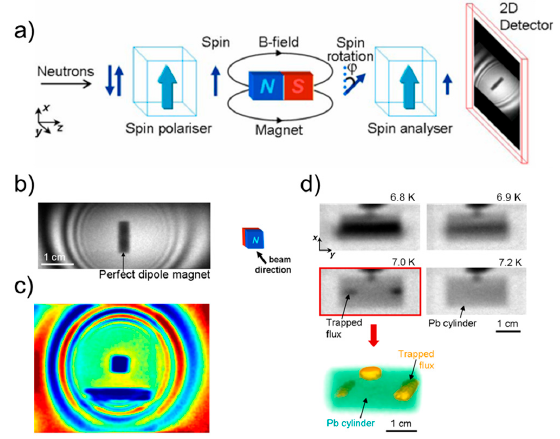
( b ) Field lines surrounding a simple dipole magnet; ( c ) Radiograph showing field lines around a bar magnet levitating over an yttrium-barium-copper-oxide (YBCO) superconductor as in its superconducting state the YBCO expels all magnetic fields and thus repels the permanent magnet (Meissner effect); ( d ) Magnetic field trapped in a polycrystalline lead cylinder at different temperatures around T c = 7.2 K. The trapped flux (yellow regions left and right) inside a polycrystalline cylinder of lead is reconstructed in 3D. When cooled to below its critical temperature in the presence of a weak magnetic field some flux is preserved inside the sample due to defects and grain boundaries and this remains trapped even after the field is switched off